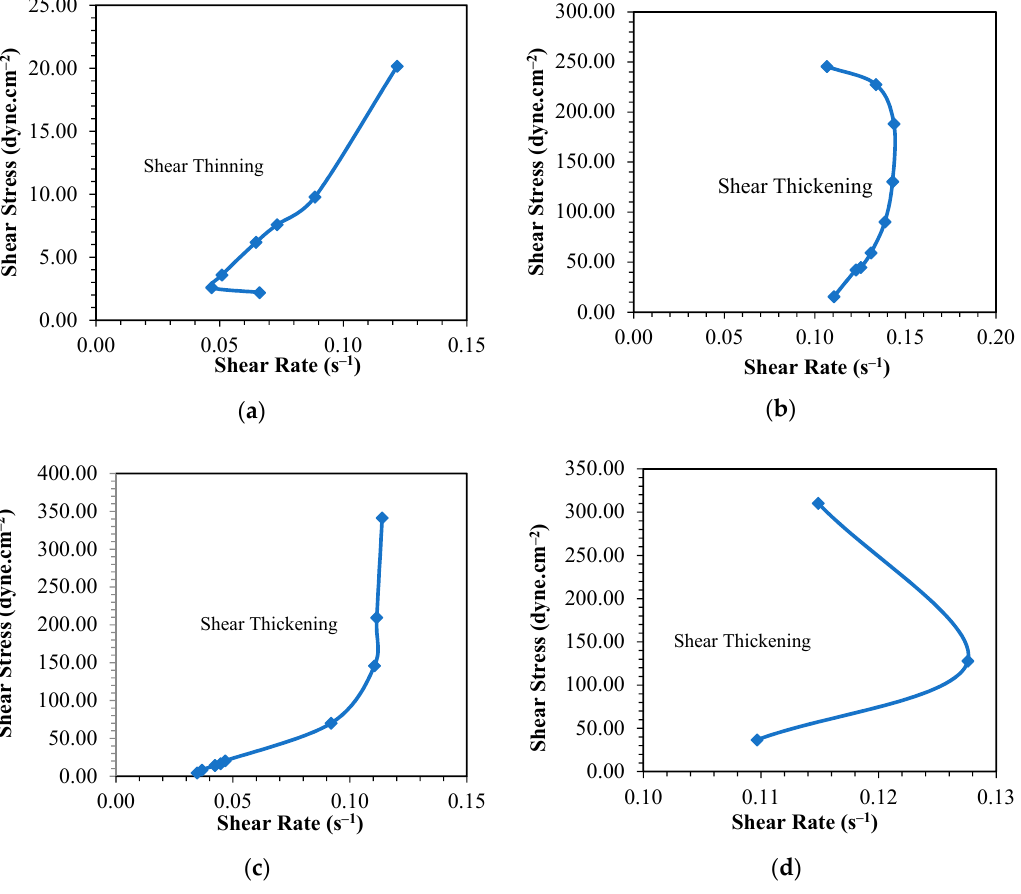
Figure 8. Curve of shear rate—shear stress for phenol formaldehyde (PF) resin (PF III) synthesis Temperature at ( a ) 40, ( b ) 60, ( c ) 80 and ( d ) 100 °C.